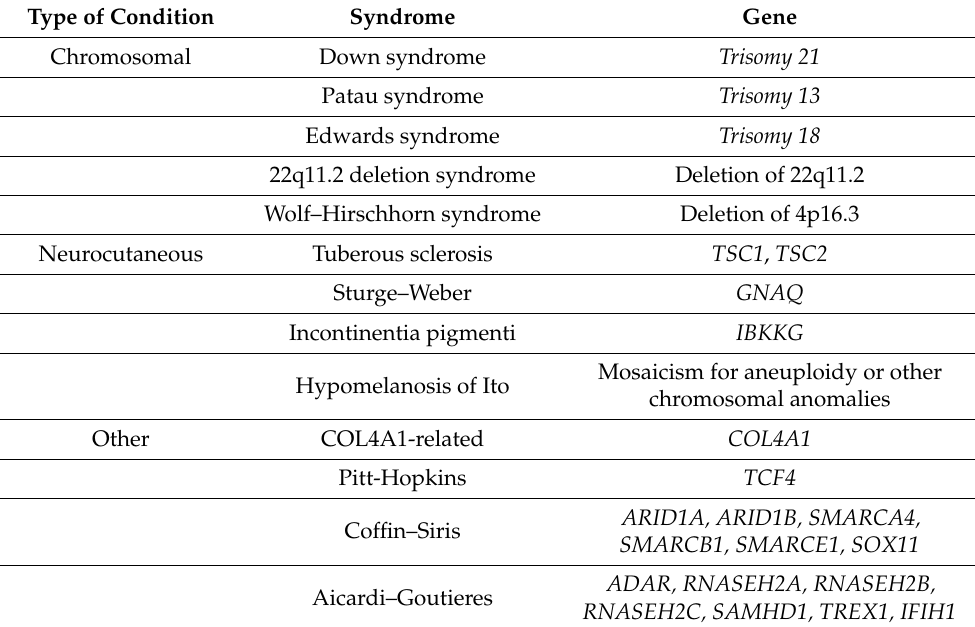
Table 3. Genetic syndromes associated with neonatal seizures